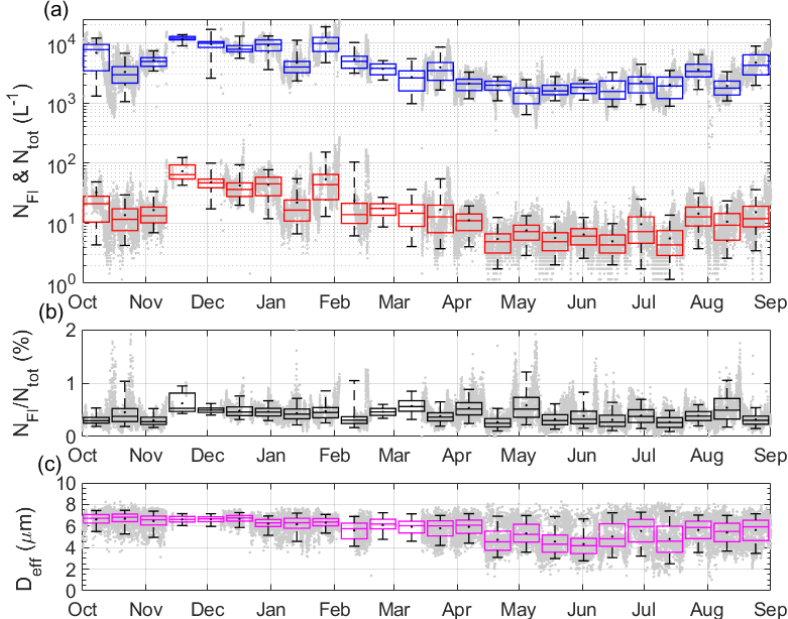
Figure 1. Panel (a) represents a box-and-whisker plot of both average fluorescent (red) and total (blue) particle concentrations from 0.8 to 10µm. Whiskers represent the 5th and 95th percentile values. Boxes represent 14d average values, with the mean shown as a black dot. Grey dots indicate 15min data. Panel (b) shows the ratio of fluorescent particle concentrations relative to total particle observations, while panel (c) shows the trend for the effective diameter (Deff) of fluorescent